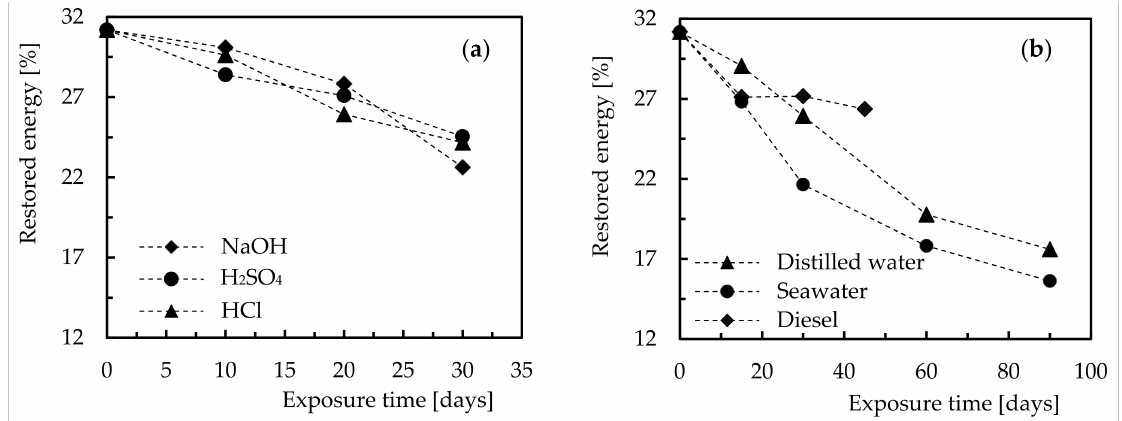
Figure 6. Influence of the exposure time on the restored energy for ( a ) NaOH, H 2 SO 4 , and HCl; ( b ) Distilled water, seawater, and diesel. Table 2. Restored energy for 30 days of immersion and comparision with the value obtained for control samples.